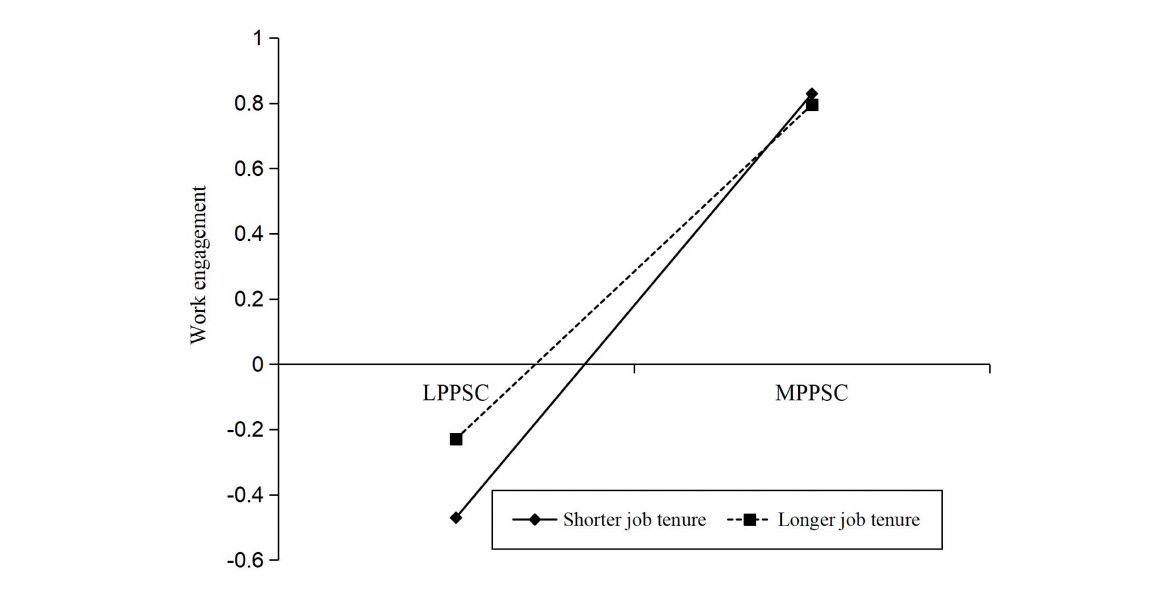
FIGURE3 Job tenure moderates the direct relationship between perceived school culture and work engagement. LPPSC, less positive perceived school culture; MPPSC, more positive perceived school